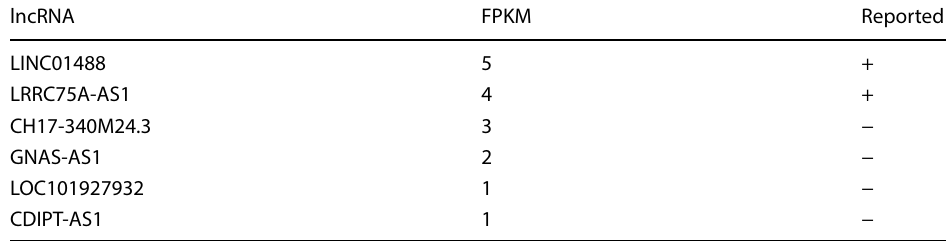
Table 2 Top six treatment- specific lncRNA transcripts in OS-P compared to OS cells